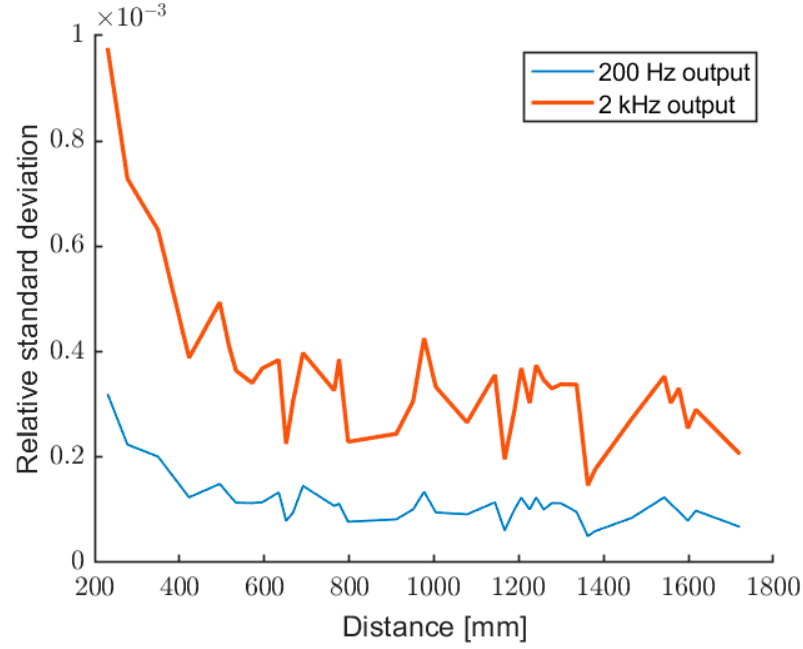
Figure 12. Relative standard deviation of the measured distance, for the outputs at 2 kHz (upper trace) and 200 Hz (after 10 averages).